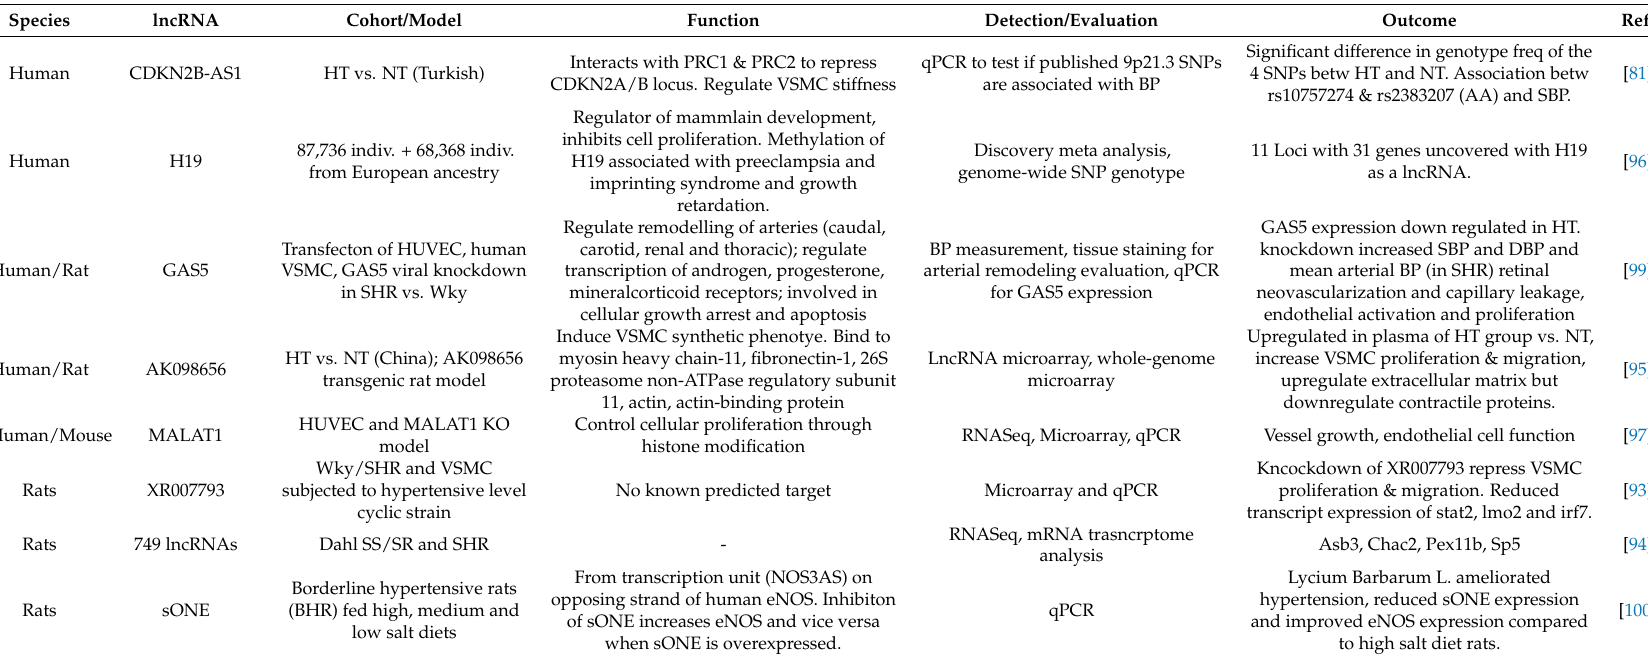
Table 4. lncRNA associated with essential